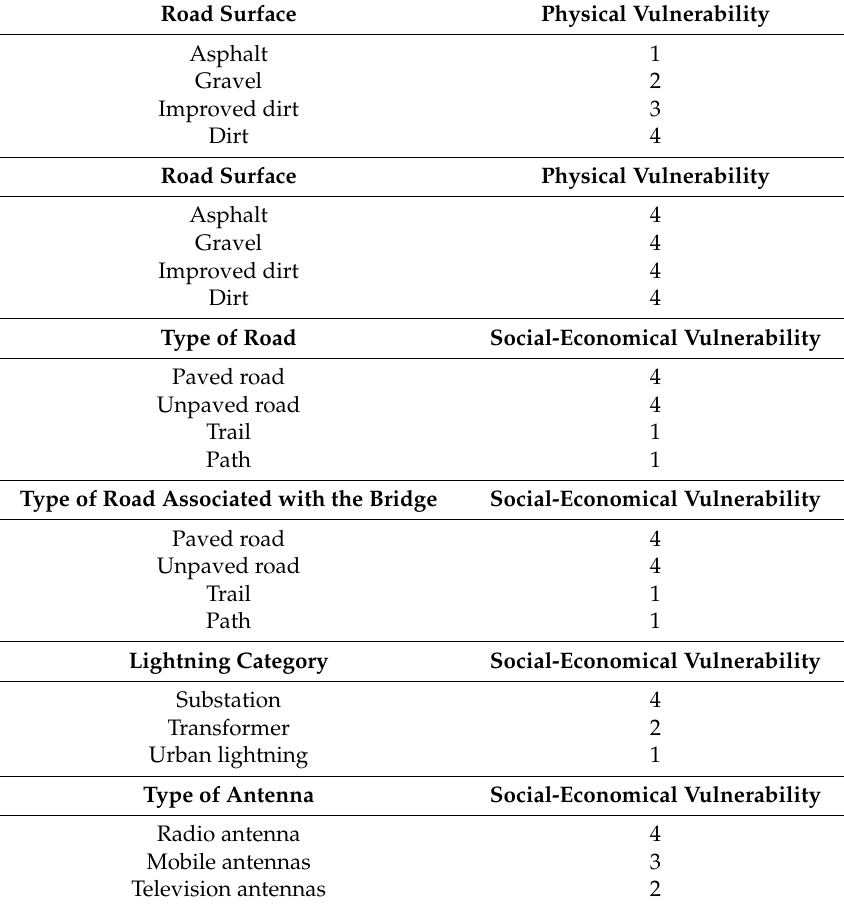
Table 6. Infrastructure physical and social-economical vulnerability (adapted from [83]). Road